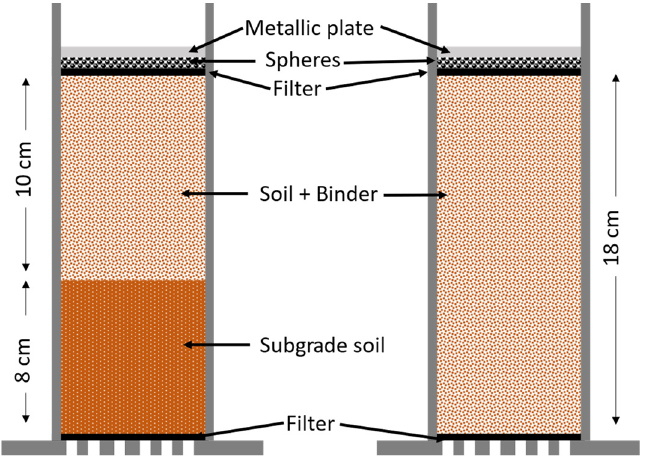
Figure 6. Schematic of swelling sample.